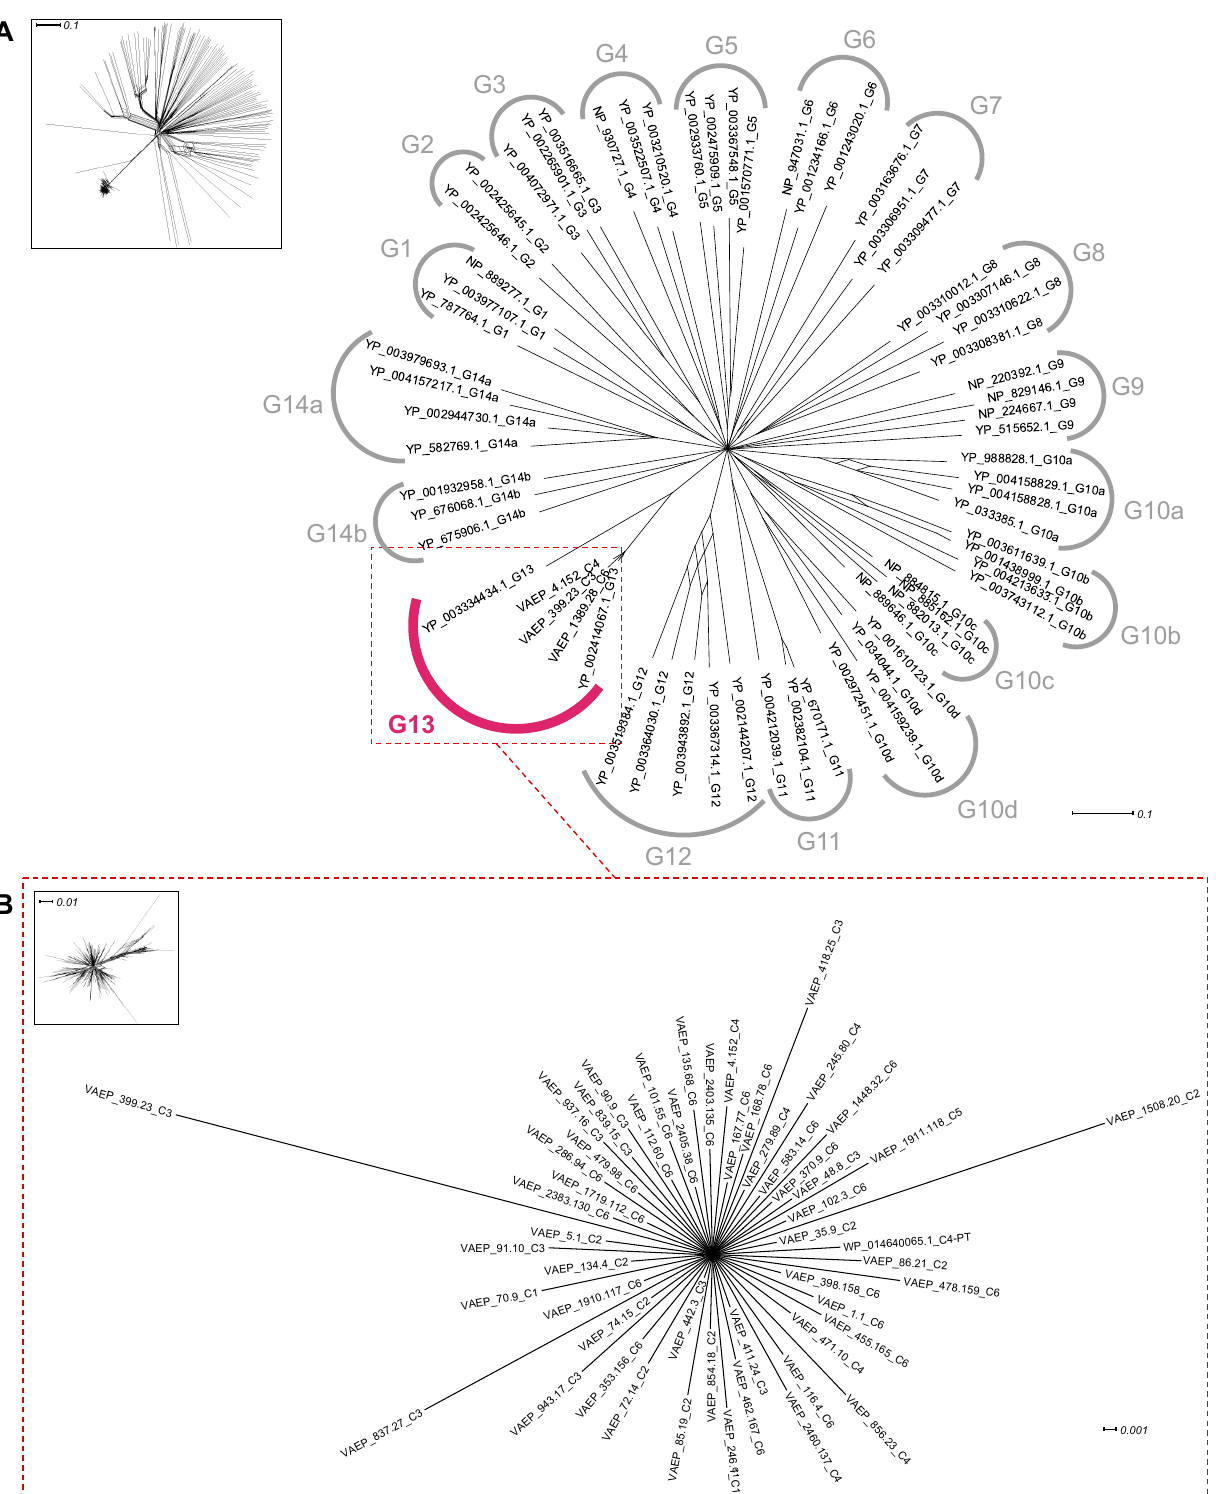
Figure 7. Phylogenetic analysis of the translocator in Ag43. Trees were generated using SplitsTree and the inserts represent the trees before applying bootstrapping and confidence threshold. ( A ) Translocator from Ag43 respective to the other translocators previously reported in ATs [34]. ( B ) Phylogenetic analyses of the Ag43 translocators. For legibility, sequences that were identified but have not been included here are available in Table S1. Scale bars represent the evolutionary distance.